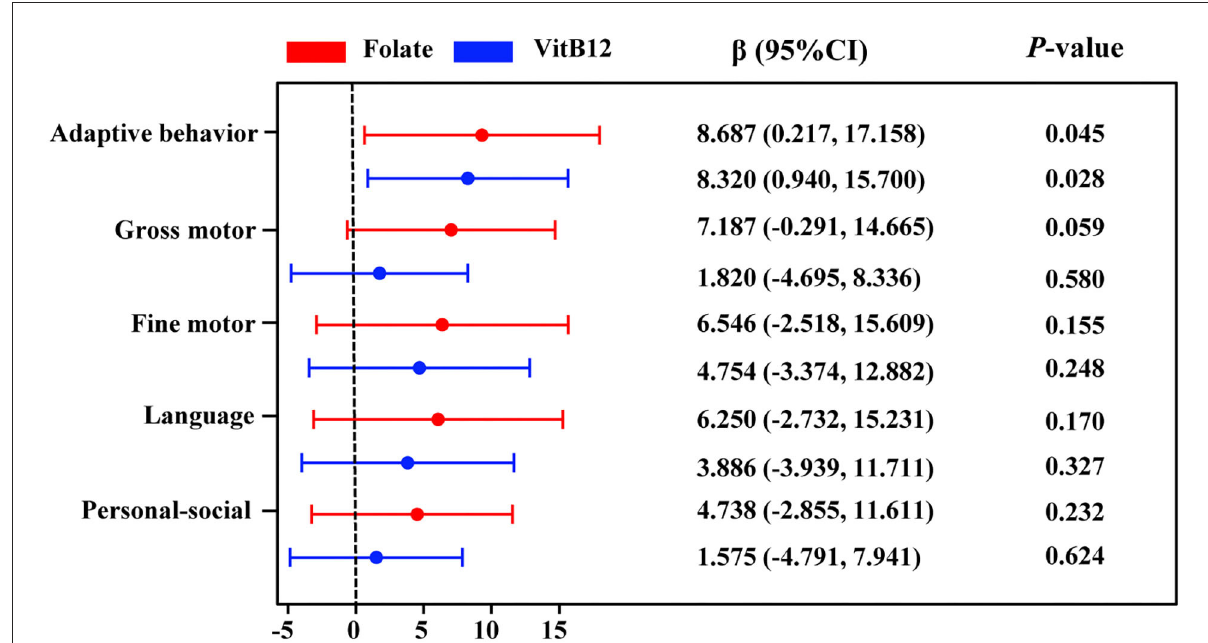
FIGURE7 Multiple linear regression for adaptive behavior, gross motor, fine motor, language, and personal–social behavior DQs with serum folate and VitB12 concentrations. Colored points represent the adjusted regression coefficient ( β ), and horizontal lines represent 95% CI adjusted for age, sex, BMI, picky eating, use of vitamins, and the other two metabolites. VitB12, vitamin